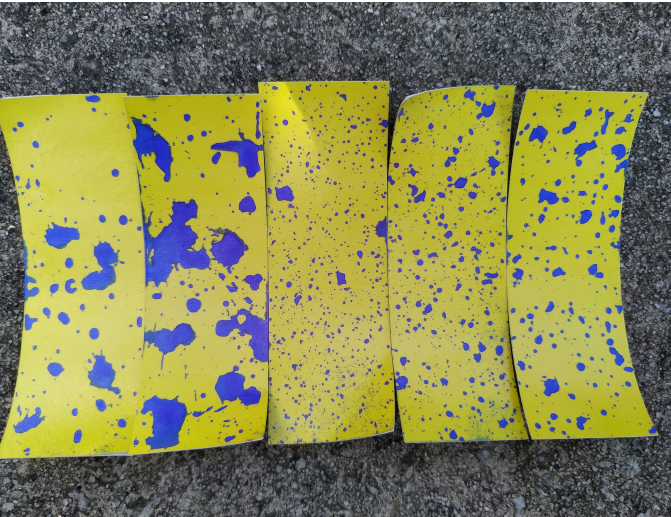
Figure 10. Water-sensitive paper results for different reference values, where the air flow was maintained and the references for the centrifugal disk and the water pump were changed. The papers represent the results of tests 1 to 5, from left to right,